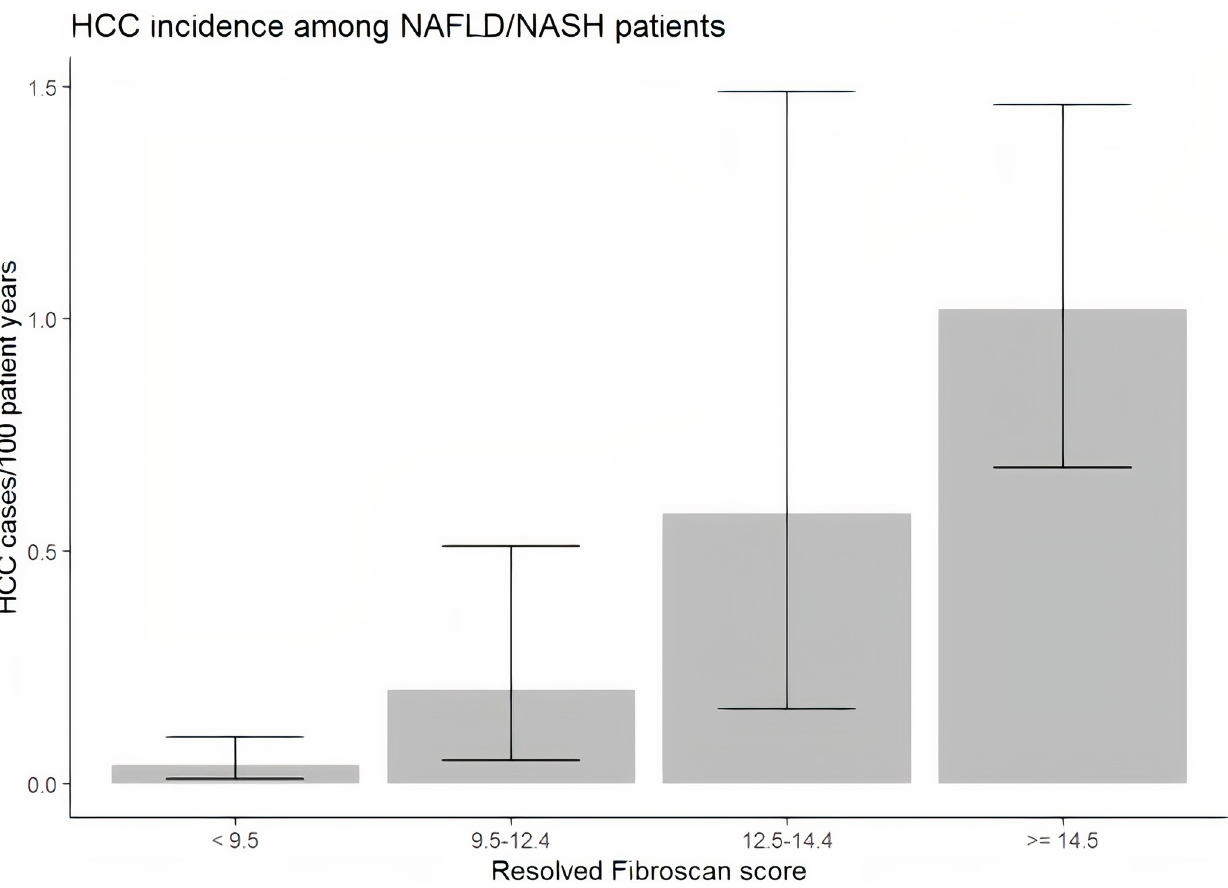
Fig 2. Incidence of HCC in veteran population with NAFLD stratified by TE score.